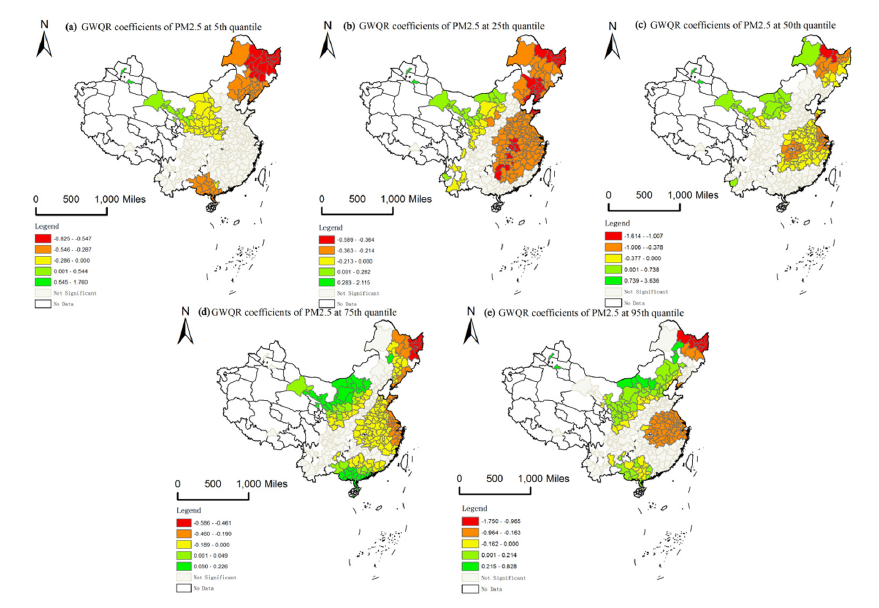
Figure A2. Spatial visualization of significant PM2.5 coefficients of GWQR for 2009. ( a )–( e ) represent the spatial distribution of significant PM2.5 coefficients for the 5th, 25th, 50th, 75th, and 95th quantiles respectively.